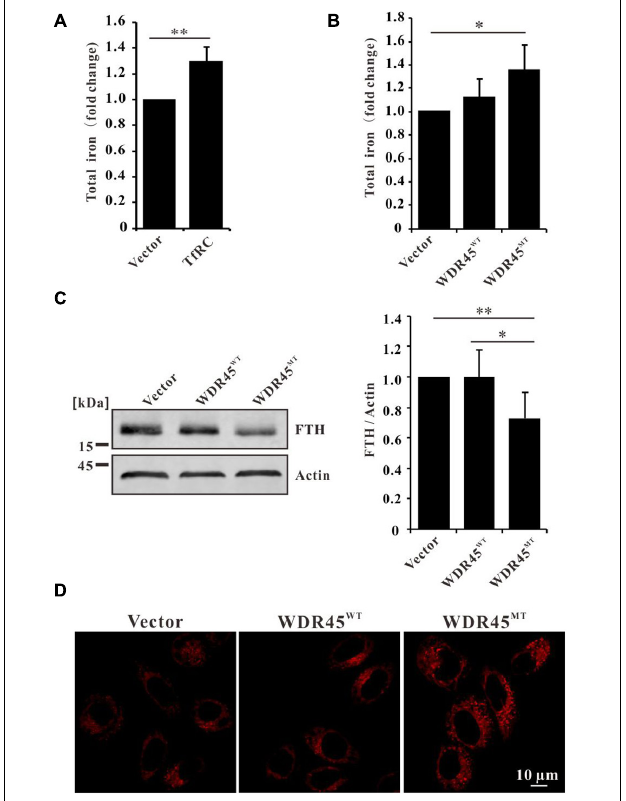
FIGURE 3 | WDR45 deficiency leads to iron overload. (A) Total iron content was elevated in HeLa cells overexpression of transferrin receptor (TfRC). (B) Total iron content was increased in WDR45 MT expressing cells. (C) Ferritin H (FTH) chain was significantly lowered in WDR45 MT expressing cells. (D) Fe 2 + was accumulated in WDR45 MT expressing cells. ** p < 0.01 and *** p <